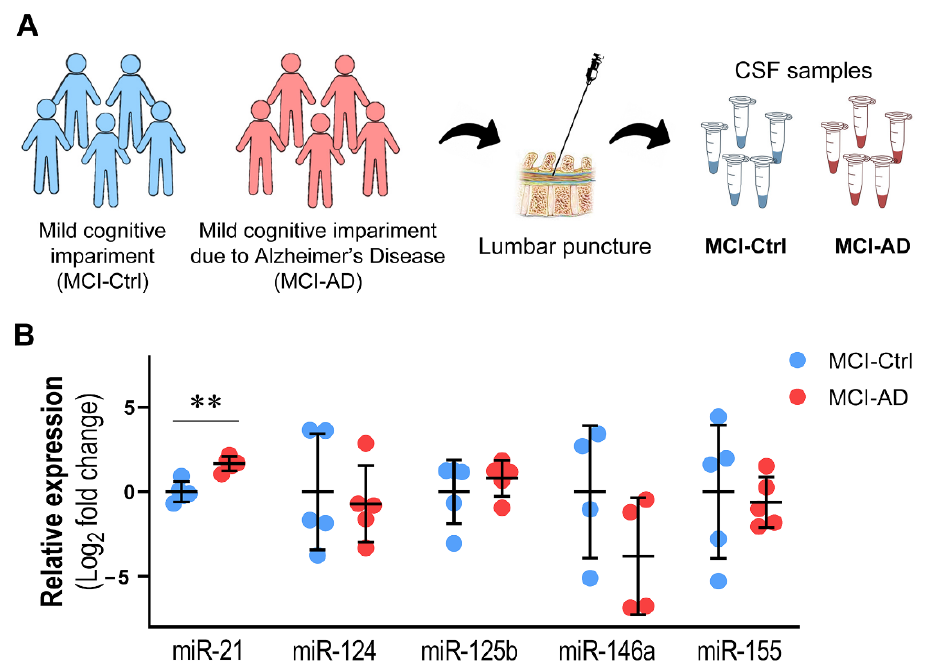
Figure 3. Exploratory miRNA profile in the cerebrospinal fluid (CSF) from MCI patients who fulfilled criteria for MCI due to AD (MCI-AD) vs. MCI patients with no biomarker criteria for AD (MCI-Ctrl). ( A ) Schematic representation of the MCI-AD and MCI-Ctrl series and the procedure to obtain CSF samples by lumbar puncture. ( B ) The miRNA profile in the CSF samples from MCI-AD (red dots) side-by-side with the miRNA profile in the CSF from MCI-Ctrl (blue dots). The results are mean ± SEM presented as the binary logarithm of fold change from five different subjects of each group. Mann–Whitney U test with Bonferroni post hoc correction: ** p < 0.01, MCI-AD vs. MCI-Ctrl.